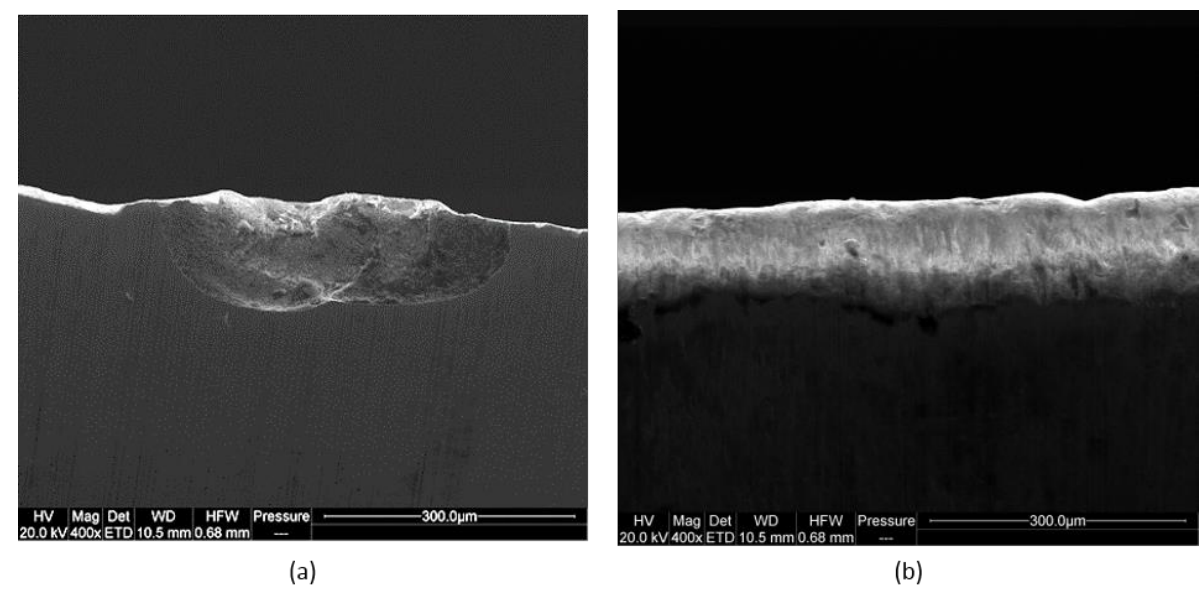
Figure 11. Wear types of tested blades ( a ) chipping ( b ) abrasion.